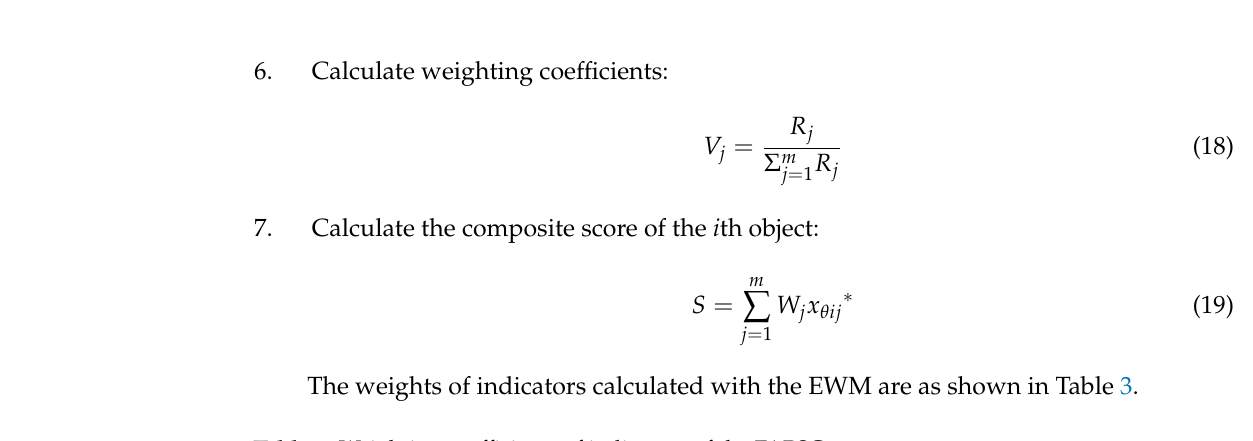
Table 3. Weighting coefficients of indicators of the